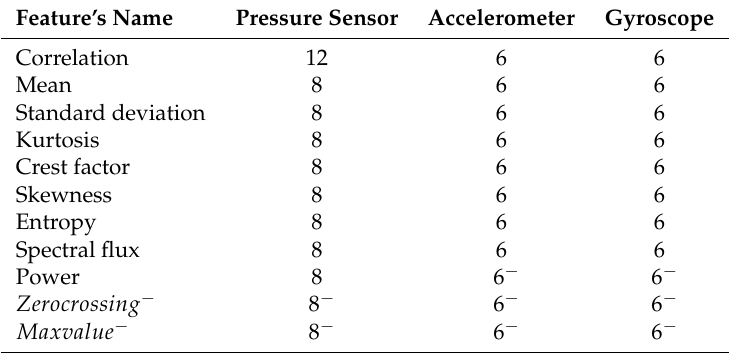
Table 2. The number of features for each